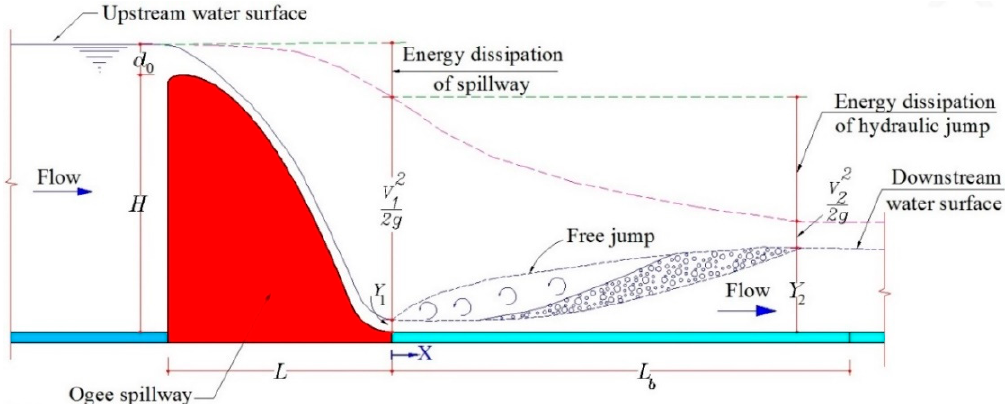
Figure 2. Description of some experimental parameters.